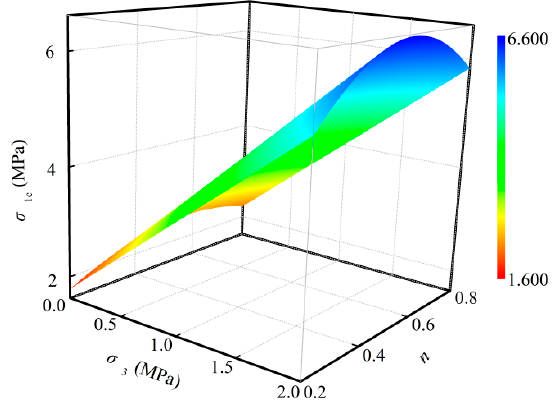
Figure 13. Relationship between the strength parameter and Talbot index of CPB specimens.